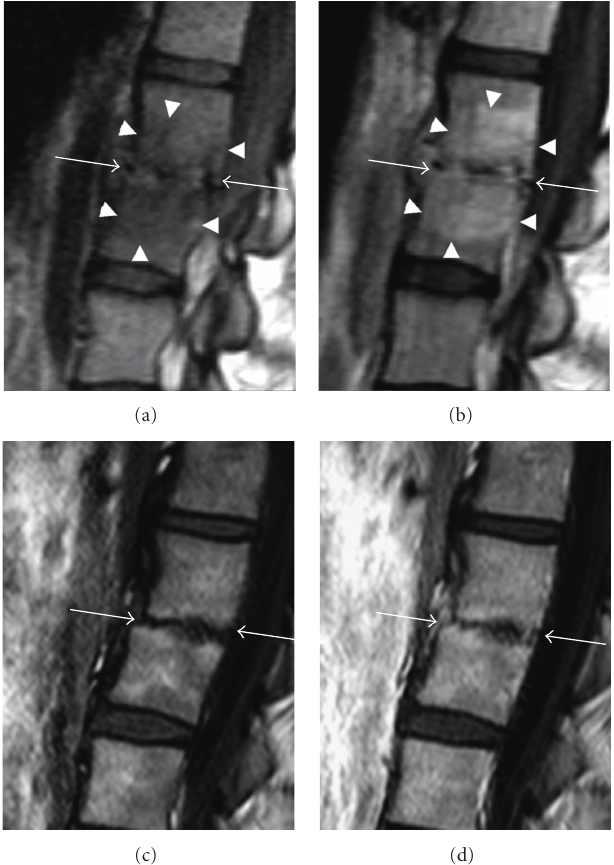
Figure 1: (a) and (b) demonstrates the acute spondylodiscitis with destruction of the intervertebral disk between vertebra lumbar 2 and 3 (arrows). (a) (T1 weighted sagittal MRI scan) demonstrates the edema in the adjacent vertebrae as low signal (arrowheads) and (b) (T1 weighted gadolinium-enhanced sagittal MRI scan) shows the enhancement of the vertebrae as high signal (arrowheads). Imaging findings are consistent with spondylodiscitis with psoas muscle abscess (not shown). After therapy, the bone marrow oedema ((c), T1 weighted sagittal MRI scan) disappeared as did the pathological gadolinium enhancement ((d), T1 weighted gadolinium-enhanced sagittal MRI scan) and the psoas abscess. The destructed disk (arrows) is the only remaining abnormality, consistent with healed